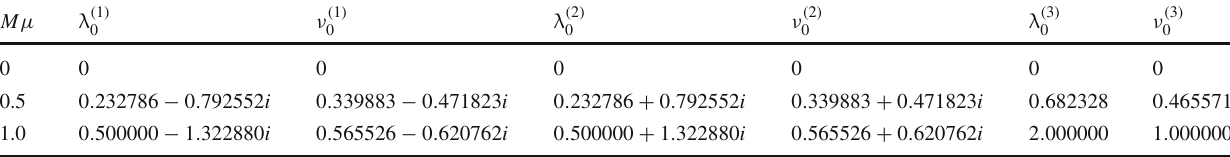
a = 0 . 1. On the bottom, we get it in the Kerr–Newman black hole for m = 1, a = 0 . 1, e = 1, and Q = 0 . 1. The units are in multiples of ( j ) C mN ; s ( j ) , in the Schwarzschild black hole spacetime 0